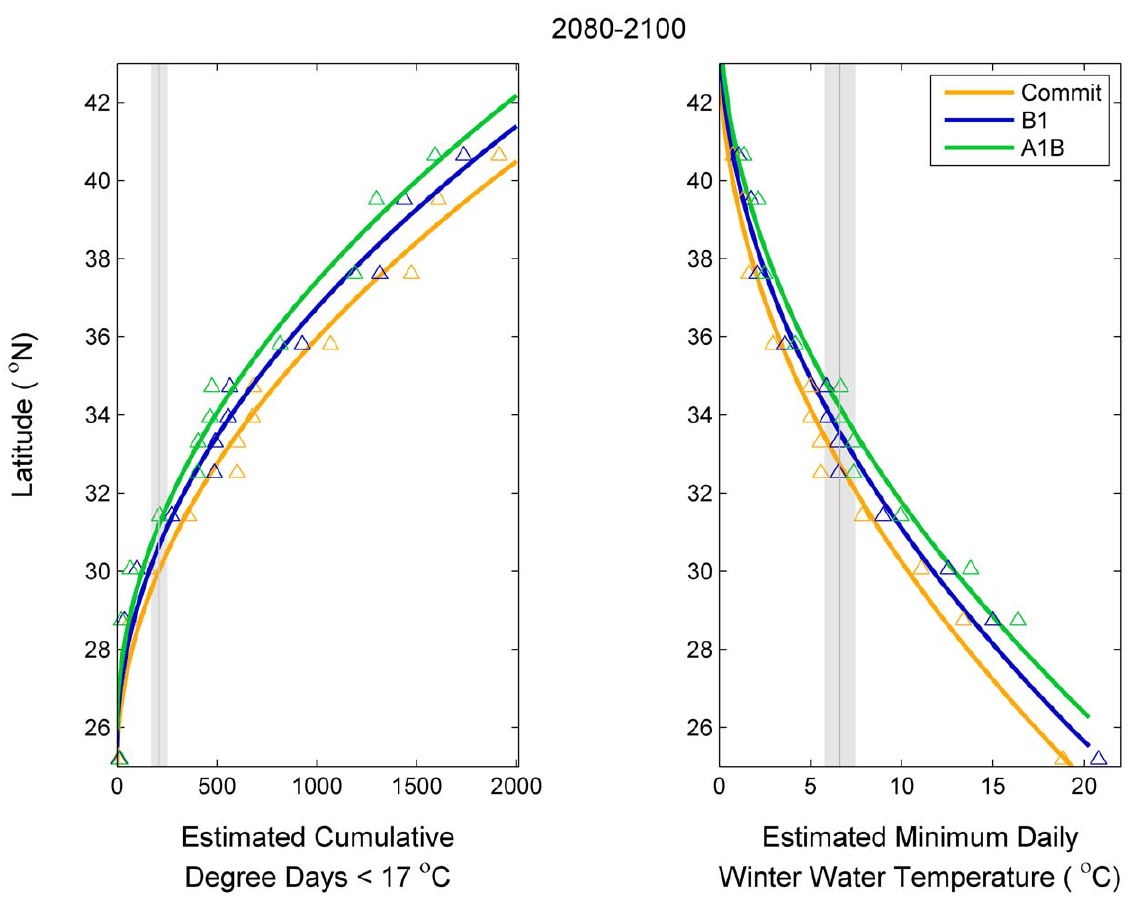
Figure 4. Estimated latitude of thermal tolerance metrics in 2080–2100 under three climate change emission scenarios. The gray line and shading represent the thermal tolerance metric and 95% confidence intervals for gray snapper juveniles as determined from an experimental study [39].